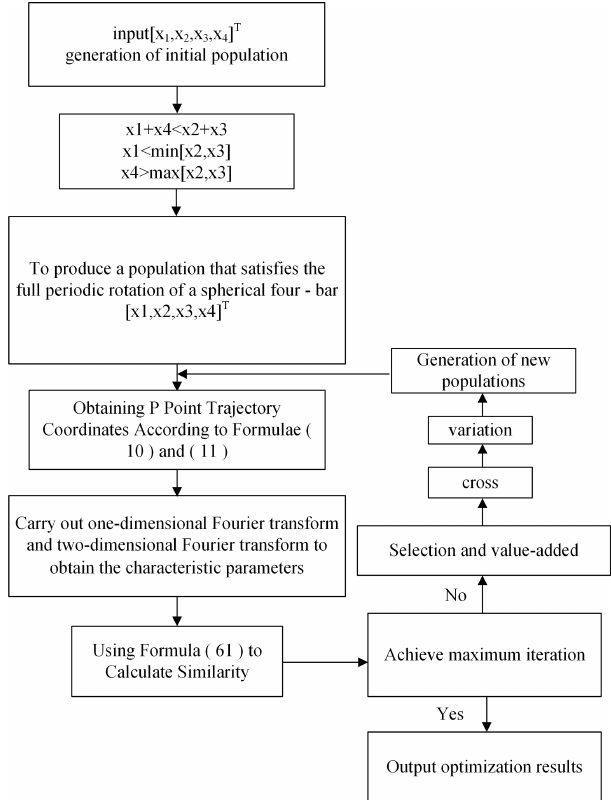
Figure 9. Optimization flowchart.